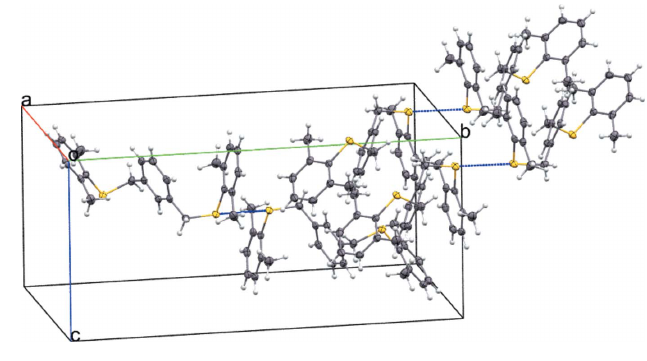
Figure 2 Partial packing diagram for the title compound. S2 (cid:3)(cid:3)(cid:3) S2 interactions are shown as blue dashed